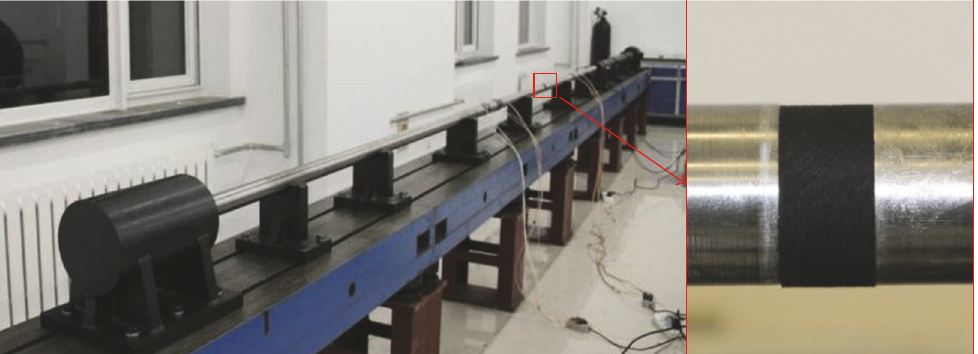
Figure 5: The diagram and physical photo of the SHPB test